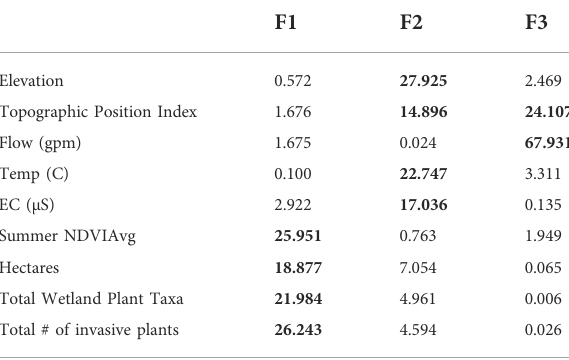
TABLE 3 Multivariate contribution of the ecohydrological parameters (%) for 48 California Desert springs to the associated PCA factors.